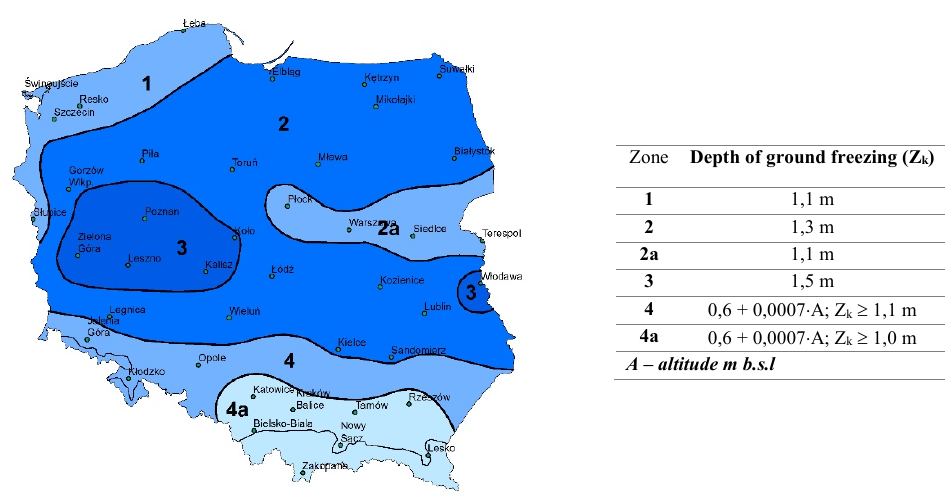
Figure 12. Proposal for a new map of ground freezing in Poland with predetermined values of the zero isotherm depth (Z k ) and ranges of special zones in Poland. Reprint with permission [31]; Copyright 2017, Building Research Institute [31].